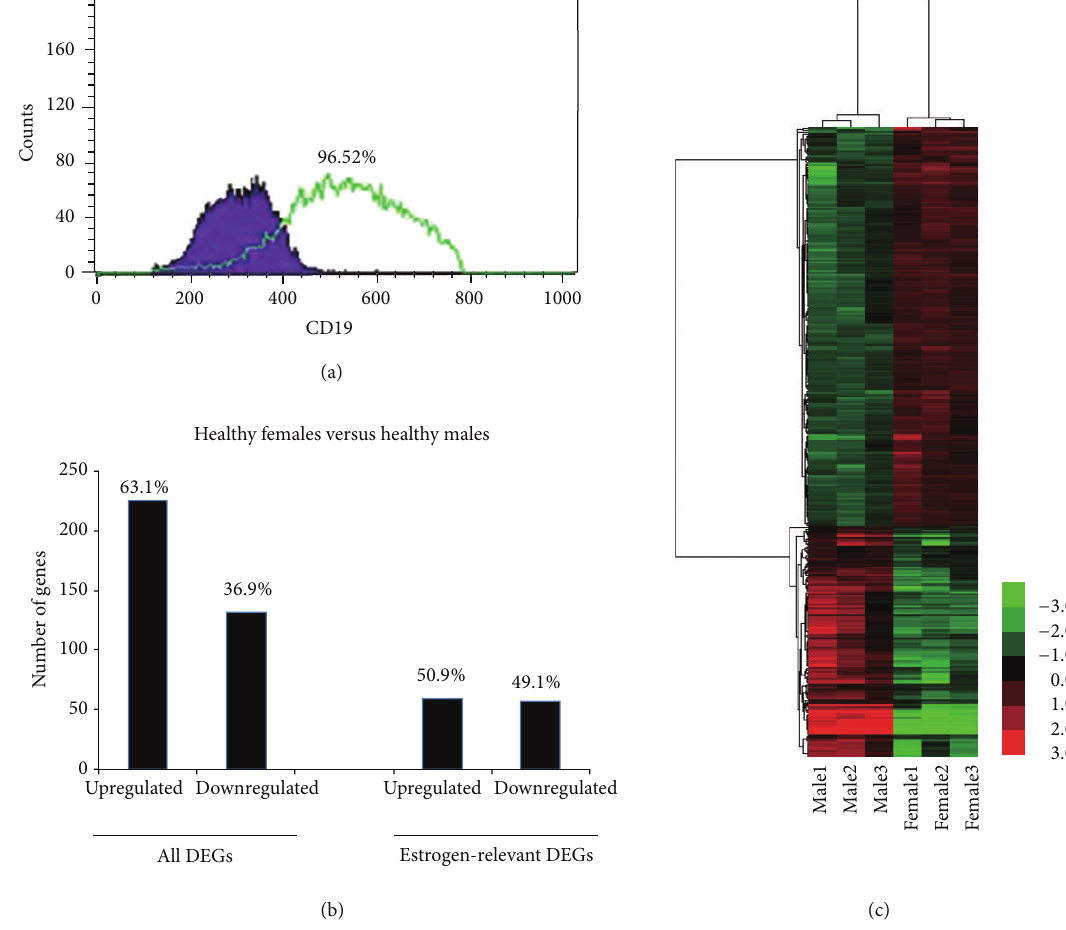
Figure 1: Gene profiling reveals differential expression genes between healthy females and males. (a) The purity of B cells was checked using CD19 antibody after selection using B cell isolation kit. (b) Hierarchical clustering of B cells of six healthy females and males using a list of 358 differentially expressed genes available on NimbleGen chips (adj. 𝑃 value < 0.05). The heat maps show the most highly changed gene expression (TOP100) in response to each stimulus. Each row in the heat maps represents a gene and each column represents a microarray sample. Red and green indicate upregulated and downregulated expression, respectively. All samples cluster in accordance with the gender of the participant, which shows a good homogeneous expression profile between healthy males’ and females’ groups. (c) The number which of genes displayed differential expression between healthy females and males. Estrogen-relevant DEGs were listed